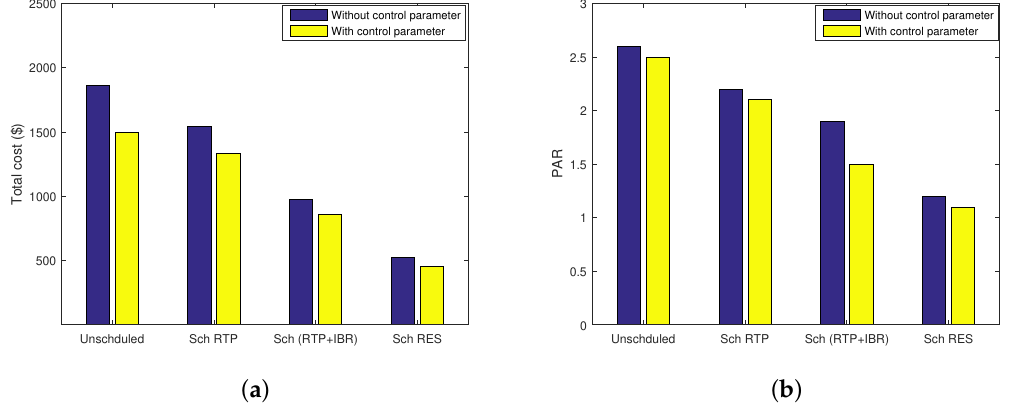
Figure 10. Total cost and PAR profiles for unscheduled and scheduled cases using; RTP, RTP+IBR and RES options. ( a ) total cost results for unscheduled, scheduled with RTP, RTP+IBR and RES, without and with control parameter; ( b ) PAR results for unscheduled, scheduled with RTP, RTP+IBR and RES, without control and with parameter control parameter.